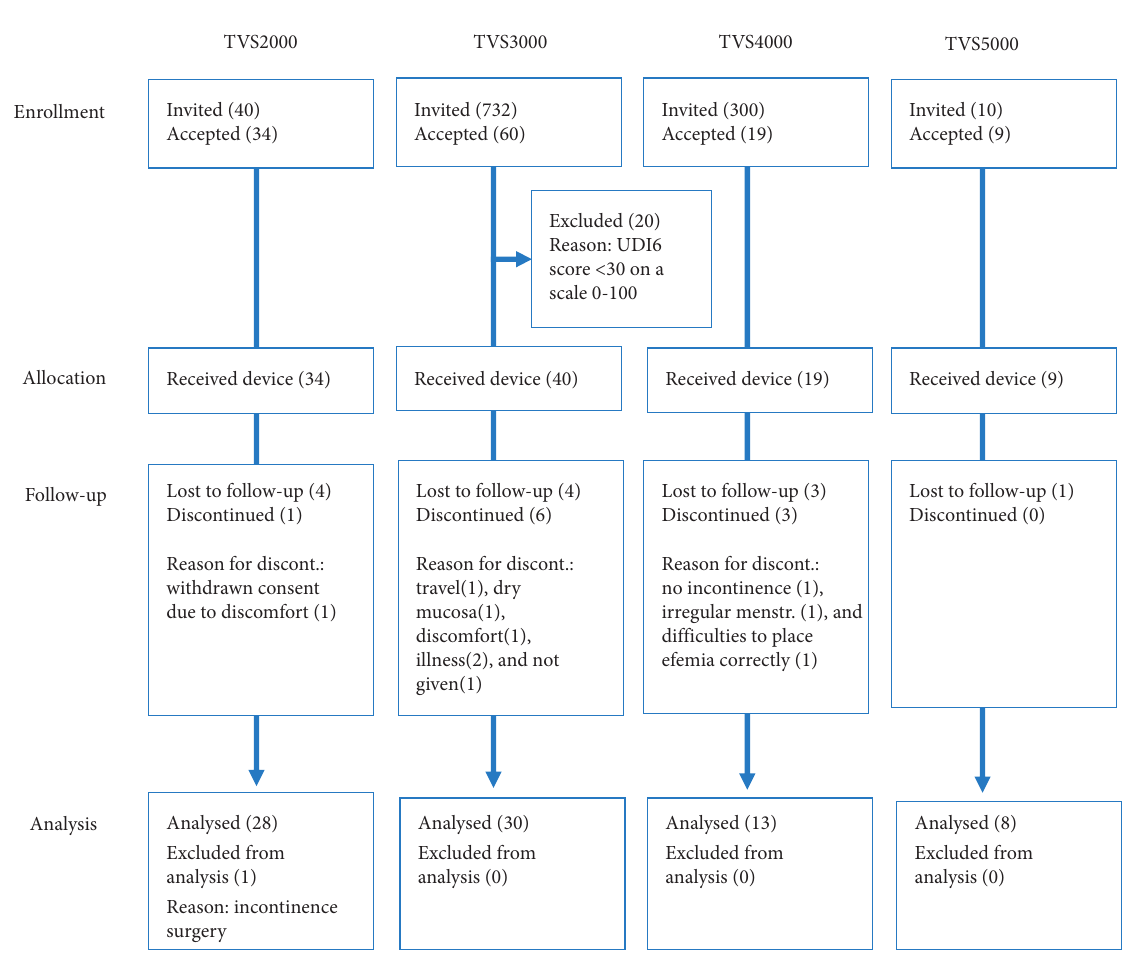
Figure 3: Participant flow, postmarket surveillance